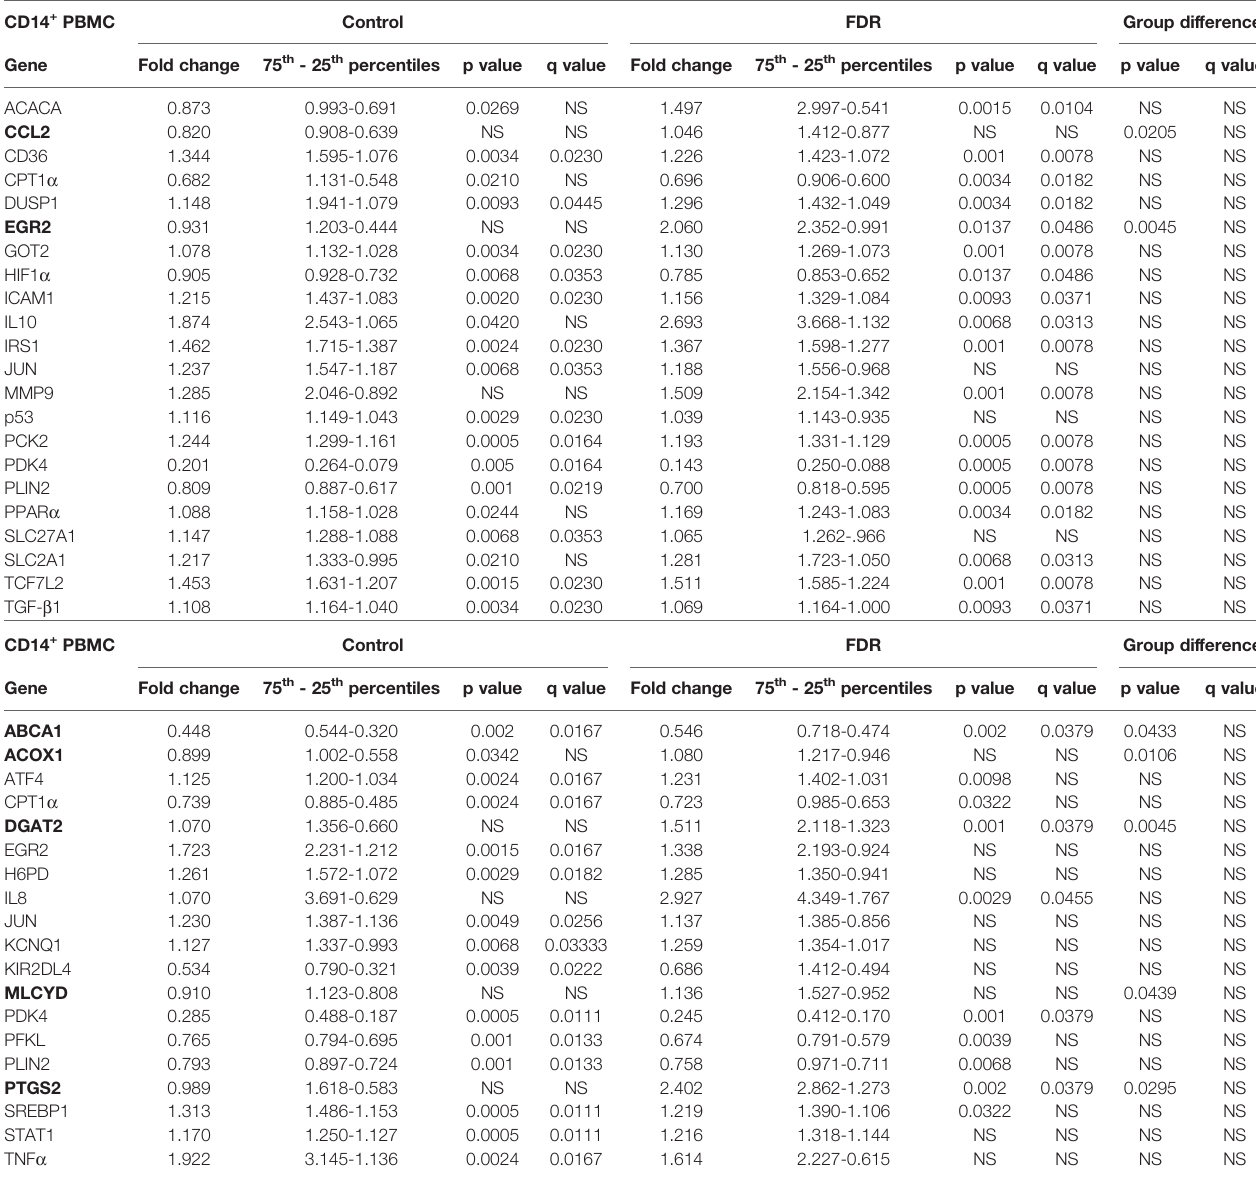
TABLE 2 | Effect of oral glucose tolerance test (OGTT) on gene expression. CD14 + PBMC Control FDR Group difference Gene q